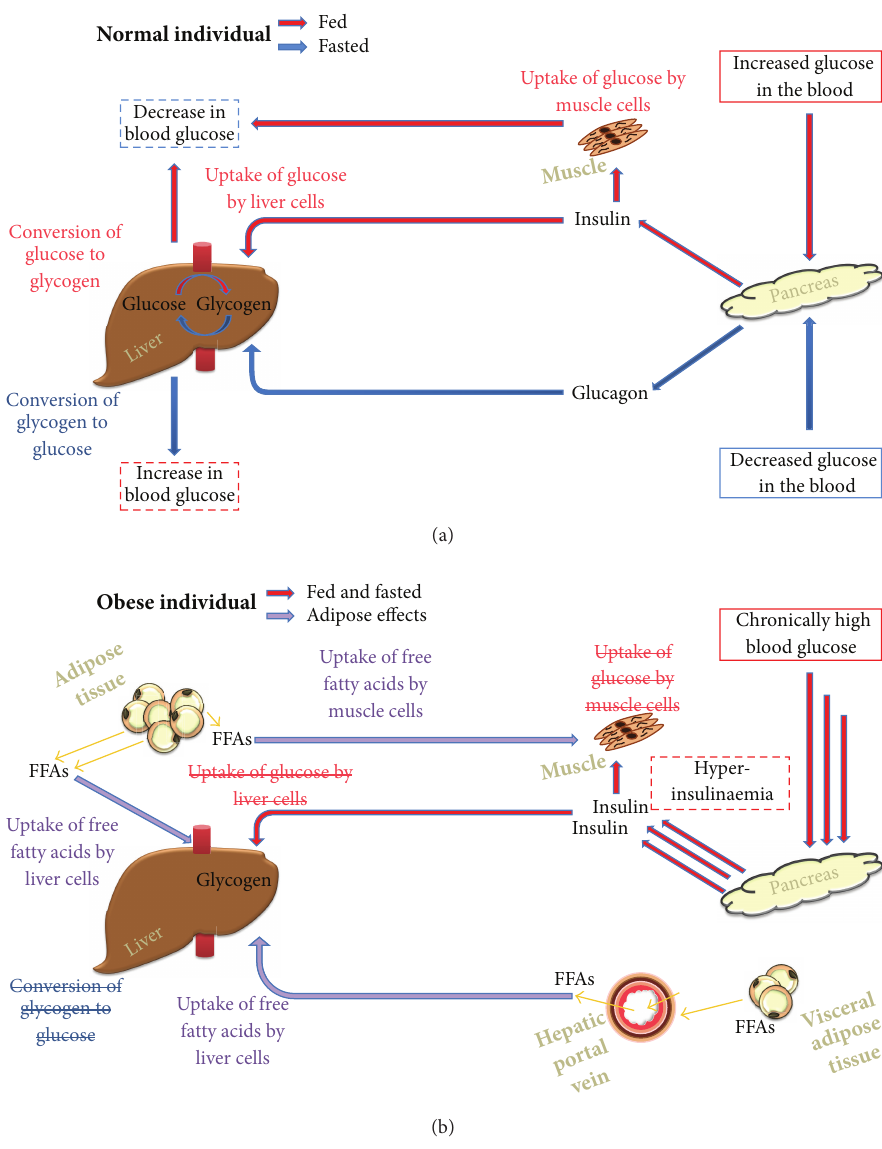
Figure 1: Insulin homeostasis in normal and obese individuals . In normal individuals, the postprandial increase in blood glucose concentration stimulates the beta cells in the Islets of Langerhans of the pancreas to release insulin (a). Insulin stimulates the uptake of glucose by liver and muscle cells and conversion of glucose to the energy store glycogen primarily in the liver and in skeletal muscle. The decrease in glucose levels in the blood of fasted individuals stimulates the alpha cells of the Islets of Langerhans in the pancreas to release glucagon. Glucagon stimulates the conversion of glycogen to glucose by glycogenolysis. In obese individuals, adipocytes in adipose tissue release nonesterified or free fatty acids (FFAs) energy into the circulation (b). The hepatic portal vein provides a direct conduit of free fatty acids from visceral adipose tissue to the liver. The high serum concentrations of nonesterified fatty acids force tissues to prioritise their oxidation as an energy source which prevents glucose uptake. Hence, the obese individual is resistant to the high levels of insulin secreted after a meal and blood glucose levels remain chronically high regardless of the fed state of the obese individual. The pancreas continues to secrete insulin in response to the high blood glucose levels. The obese individual manifests hyperglycaemia and